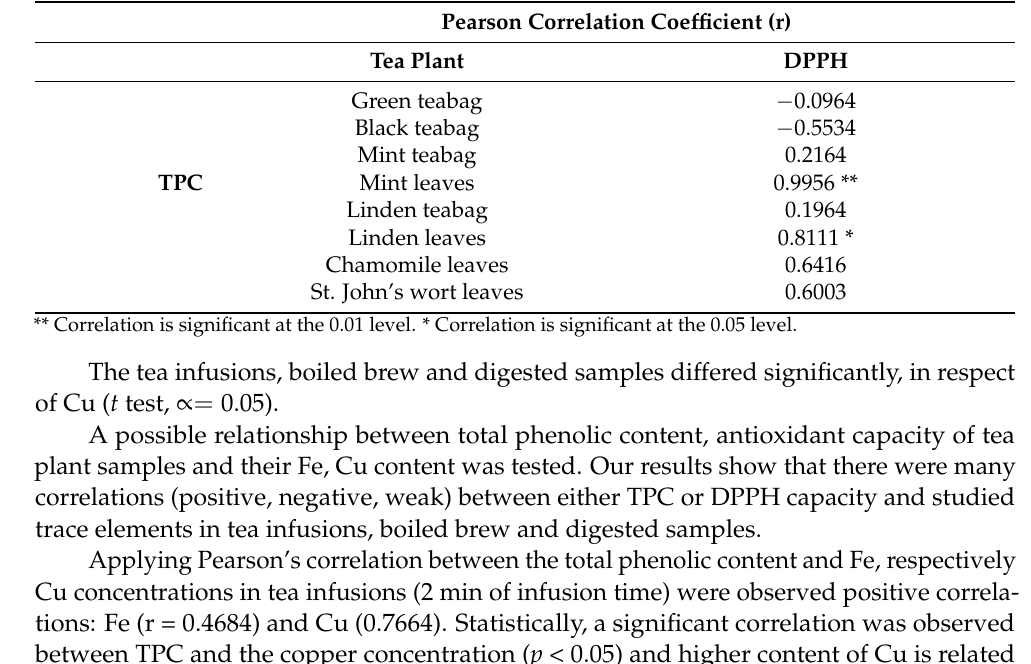
Table 6. Pearson correlation coefficients of TPC and DPPH of tea plant